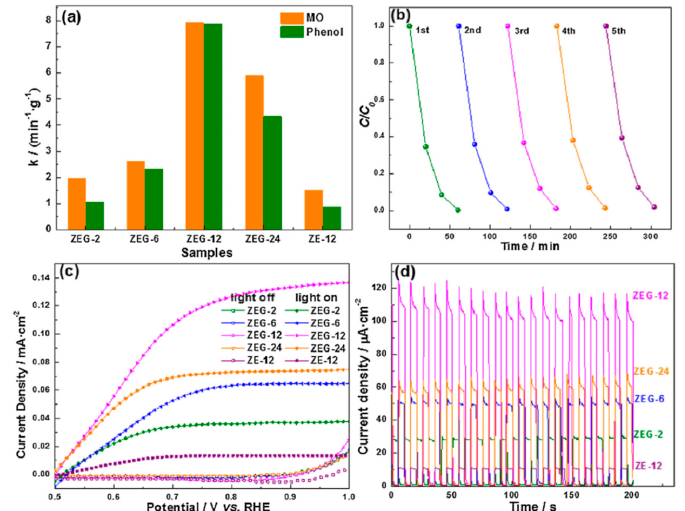
Figure 12. ( a ) The reaction rate for methyl orange (MO) and phenol photodegradation under UV-VIS irradiation; ( b ) the recycling of MO photodegradation using ZEG-12; ( c ) photocurrent–voltage (I–V) curves of ZnO in dark and under irradiation; ( d ) transient photocurrent (I–t plots) at 0.85 V vs. RHE. From Ref. [91]. Reprinted with permission from Elsevier.